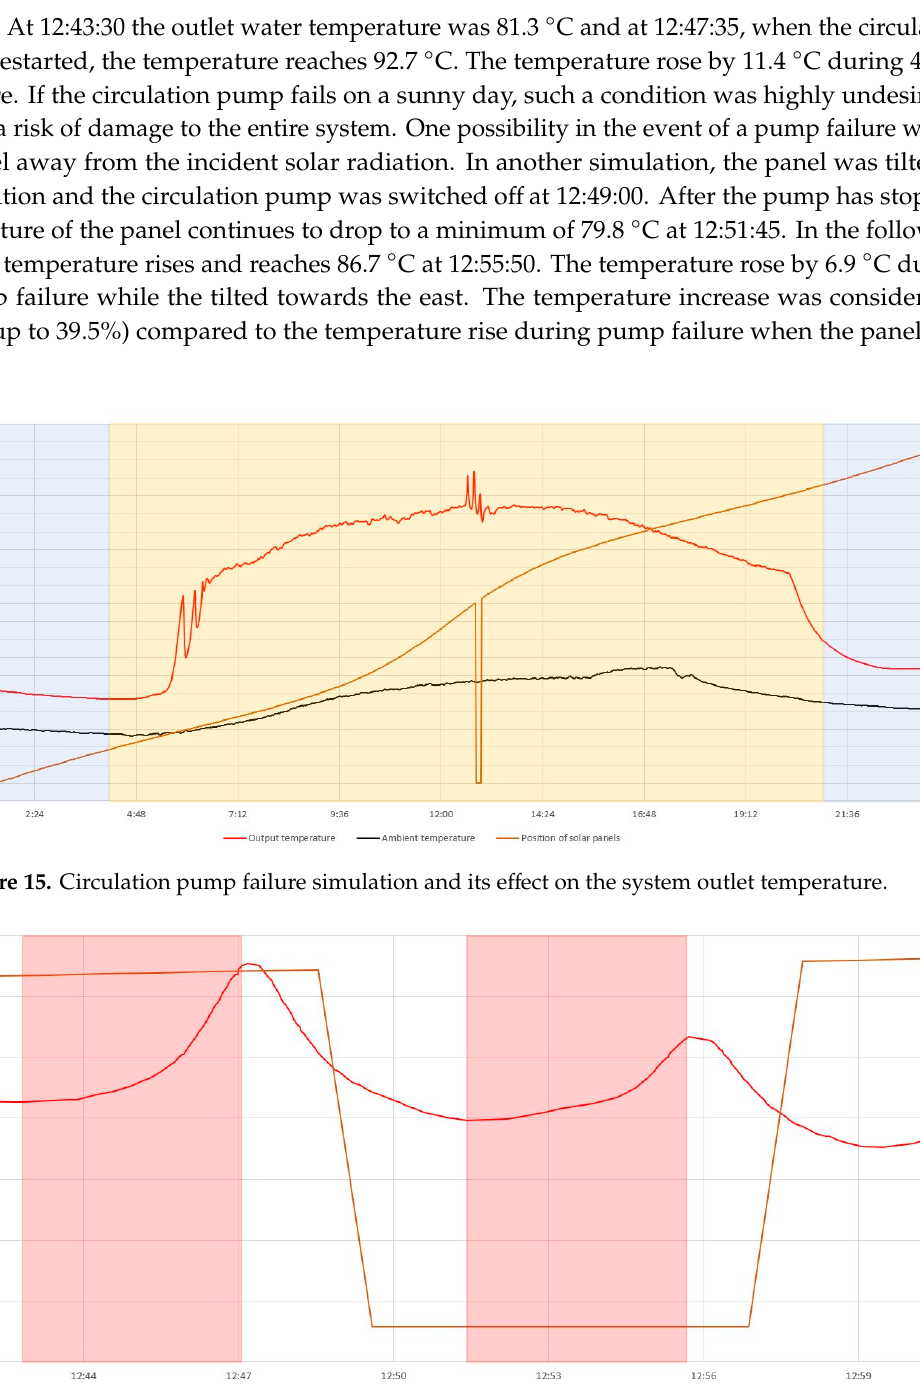
Figure 14. Flow of system inlet and outlet temperatures, outside and storage temperatures during a sunny day.